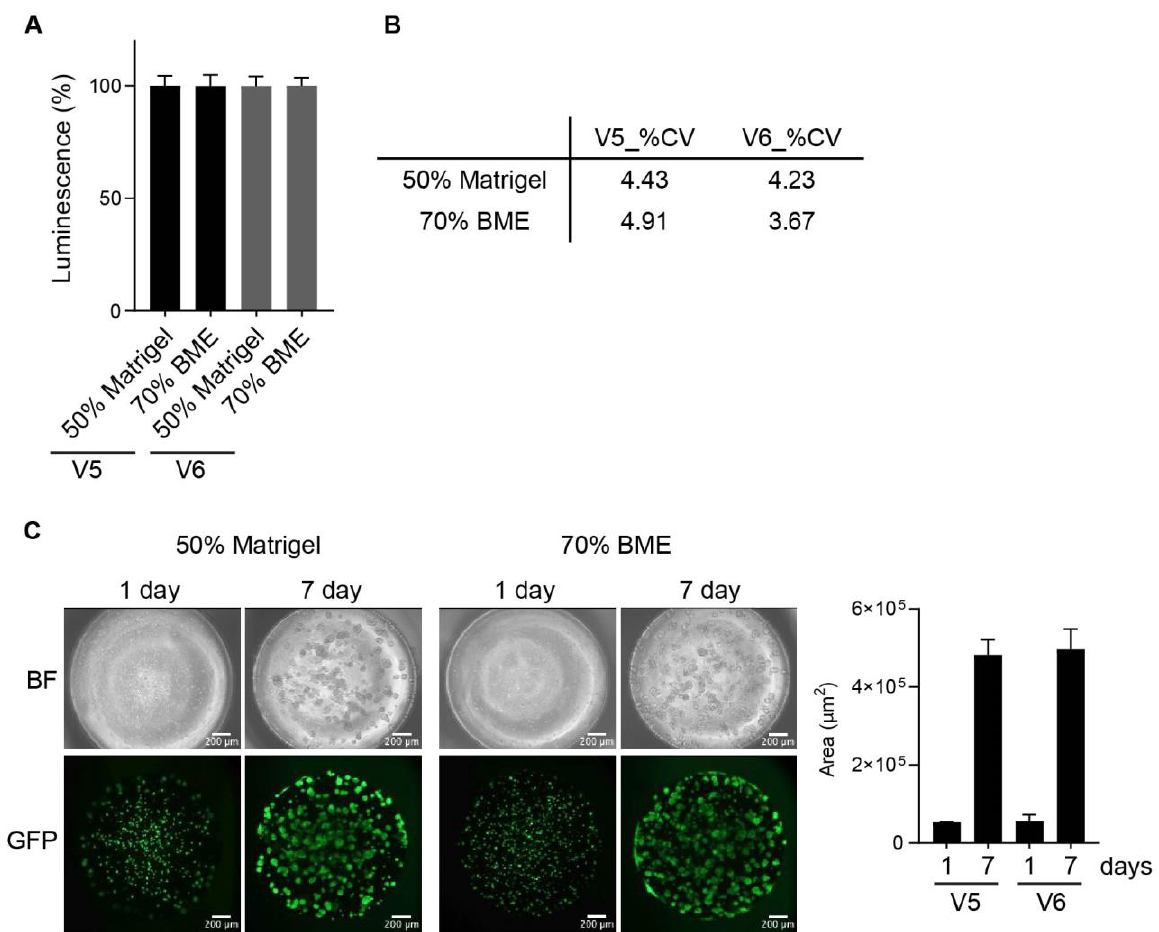
Figure 4. Applicable to growth in 3D. ( A ) A549 cells expressing GFP were dispensed with 50% Matrigel and 70% BME via ASFA SPOTTERs V5 and V6. Luminescence was then observed to confirm dispensing accuracy and precision. ( B ) The coefficient of variation (%CV) was calculated by dividing the mean value of luminescence by the standard deviation and then multiplying it by 100. ( C ) Cells were grown for a week after being dispensed onto the 384-pillar plates, and observation and analysis were then performed using an ASFA Analyzer.